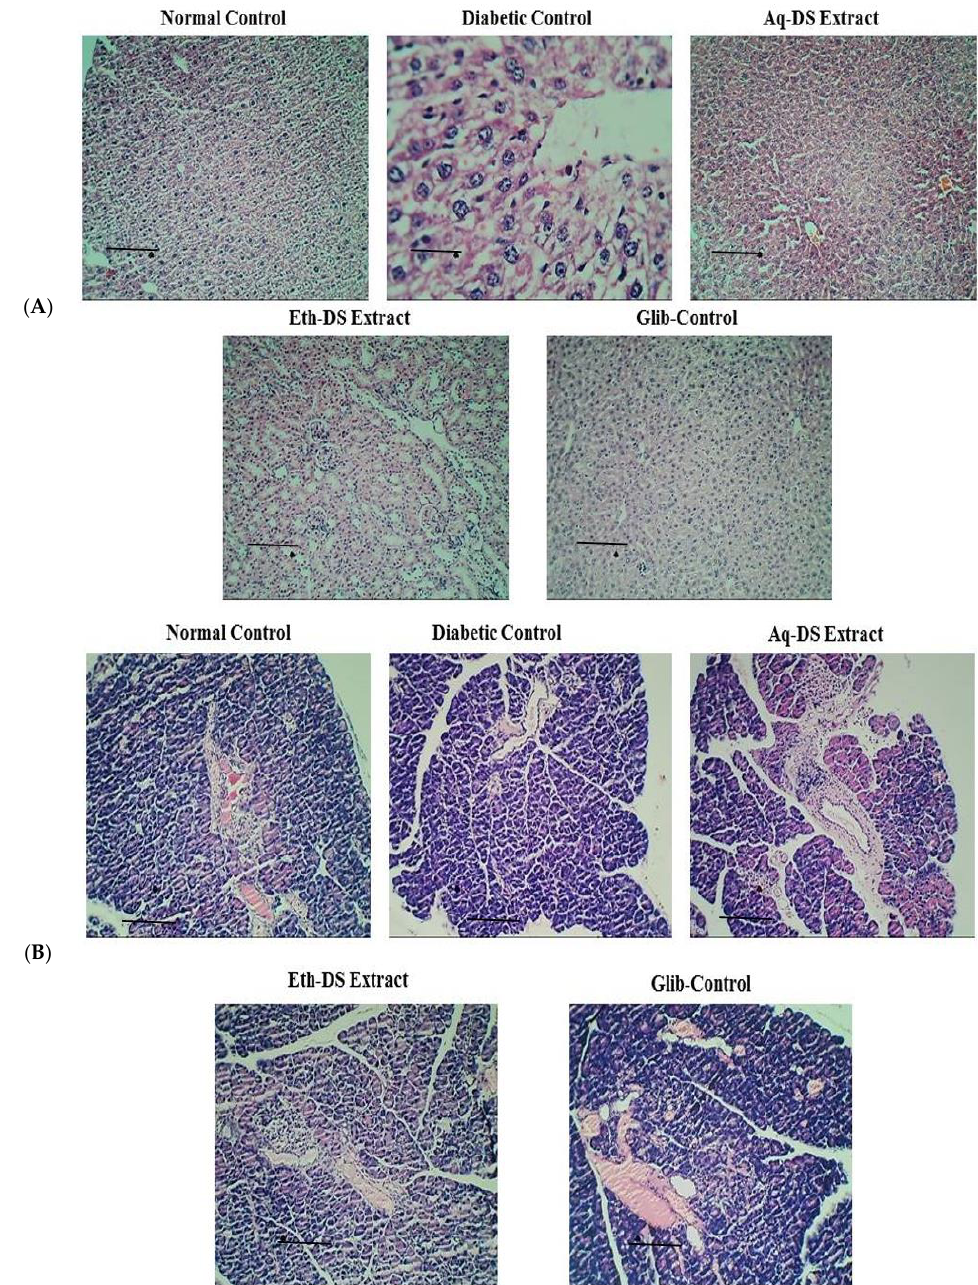
Figure 7. Photomicrographs of the effect of different treatments on ( A ) Liver architecture. Liver of control group showed normal hepatocytes architecture. Photomicrograph of diabetic group exhibited cell necrosis and sinusoidal dilation. Photomicrograph of aqueous and ethanol extract (500 mg/kg) treated groups revealed almost same morphology as normal group with normal hepatocytes architec- ture (H & E stain, × 10 & 40). ( B ) Pancreas, Pancreas of normal control mice showed normal islets surrounded with exocrine portion. Pancreas sections of diabetic mice revealed necrosis and shrinkage of islet cells. In photomicrographs from aqueous extract (500 mg/kg) treated group, enlarged islets were evident. Improved islet size and normal pancreatic structure was observed in pancreas of ethanol extract (500 mg/kg) and glibenclamide (5 mg/kg) treated groups (H & E stain, 10 × & 40 × ). Scale Bars: ( A , B ) = 0.5 cm. (Eth-DS: Ethanolic extract of DS, Aq-DS: Aqueous extract of DS, Glib: glibenclamide treated